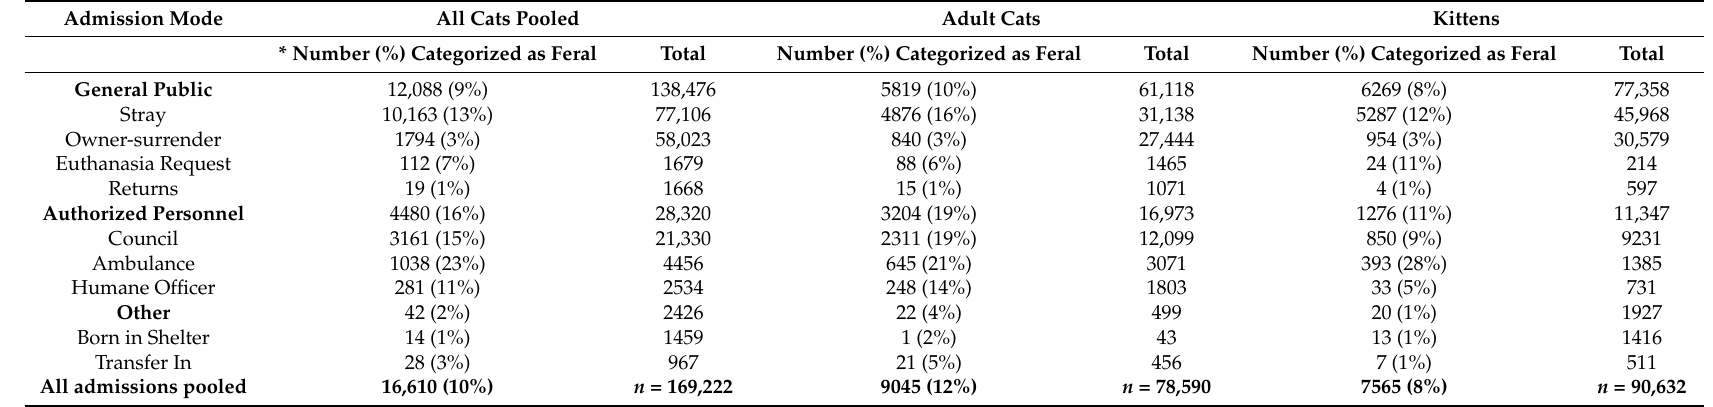
Table 3. Numbers and percentages of admissions to 39 RSPCA shelters between June 2006 and July 2010 where the cat was categorised as feral by admission mode and age. Only the 169,222 admissions where feral status ( i.e. , not feral or feral) was recorded are included.